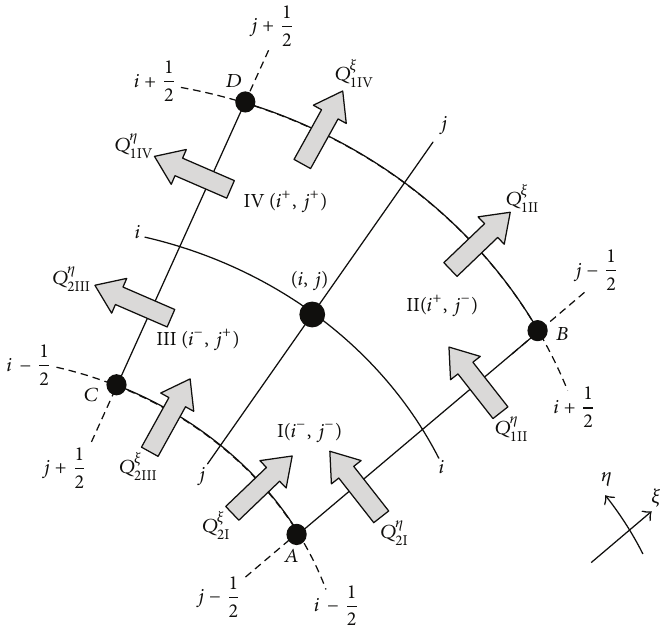
Figure 10: Definition of control volume.